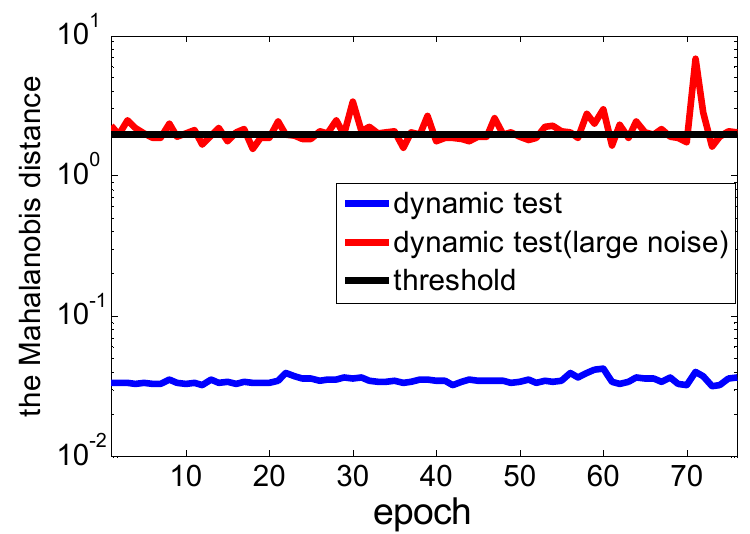
Figure 15. The hypothesis test based on Mahalanobis distance.